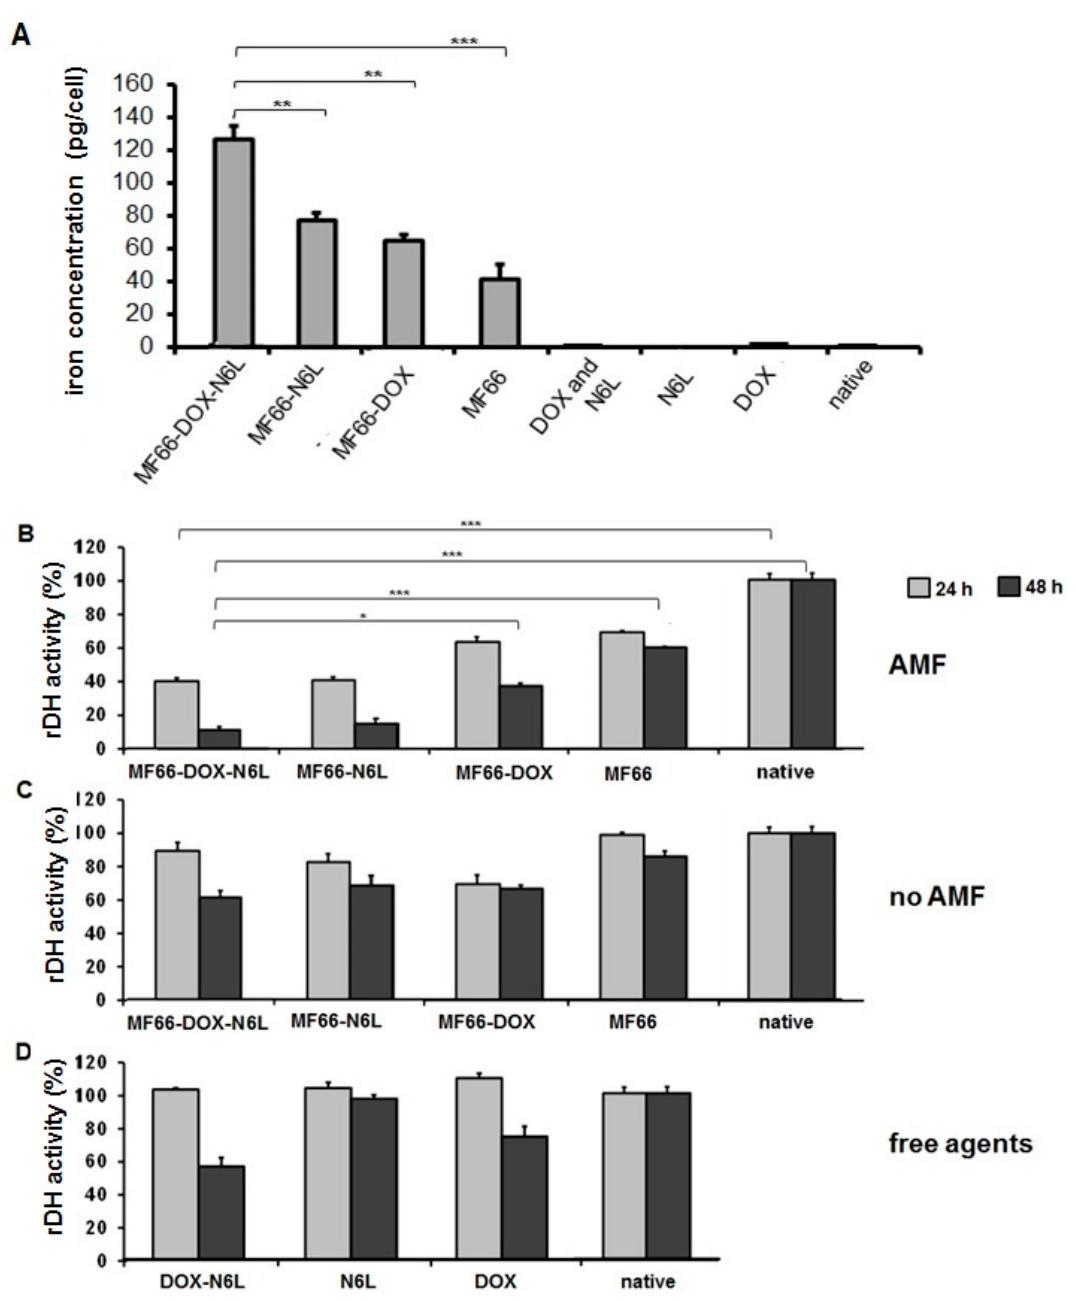
Figure 5. The additional ligand N6L on the surface of DOX-functionalized MNPs increases their internalization into BT474 cells and further inhibits tumor cell growth in combination with magnetic hyperthermia in vitro. ( A ) Intracellular iron content measured in the cells at 24 h after incubation with MNP formulations. Mean ± standard deviation of n ≥ 6 samples / group, p ≤ 0.01 (**) and p ≤ 0.001 (***). ( B ) The relative dehydrogenase activity was measured 24 h or 48 h after incubation with MNP formulations and the alternating magnetic field (AMF) treatment, ( C ) MNP application without AMF and ( D ) treatment with the free ligands. AMF settings: H = 23.9 kA/m, f = 410 kHz, 43 °C for 60 min. Means and standard deviation of three individual experiments with three parallels each, (*) p ≤ 0.05 and (***) p ≤ 0.001.